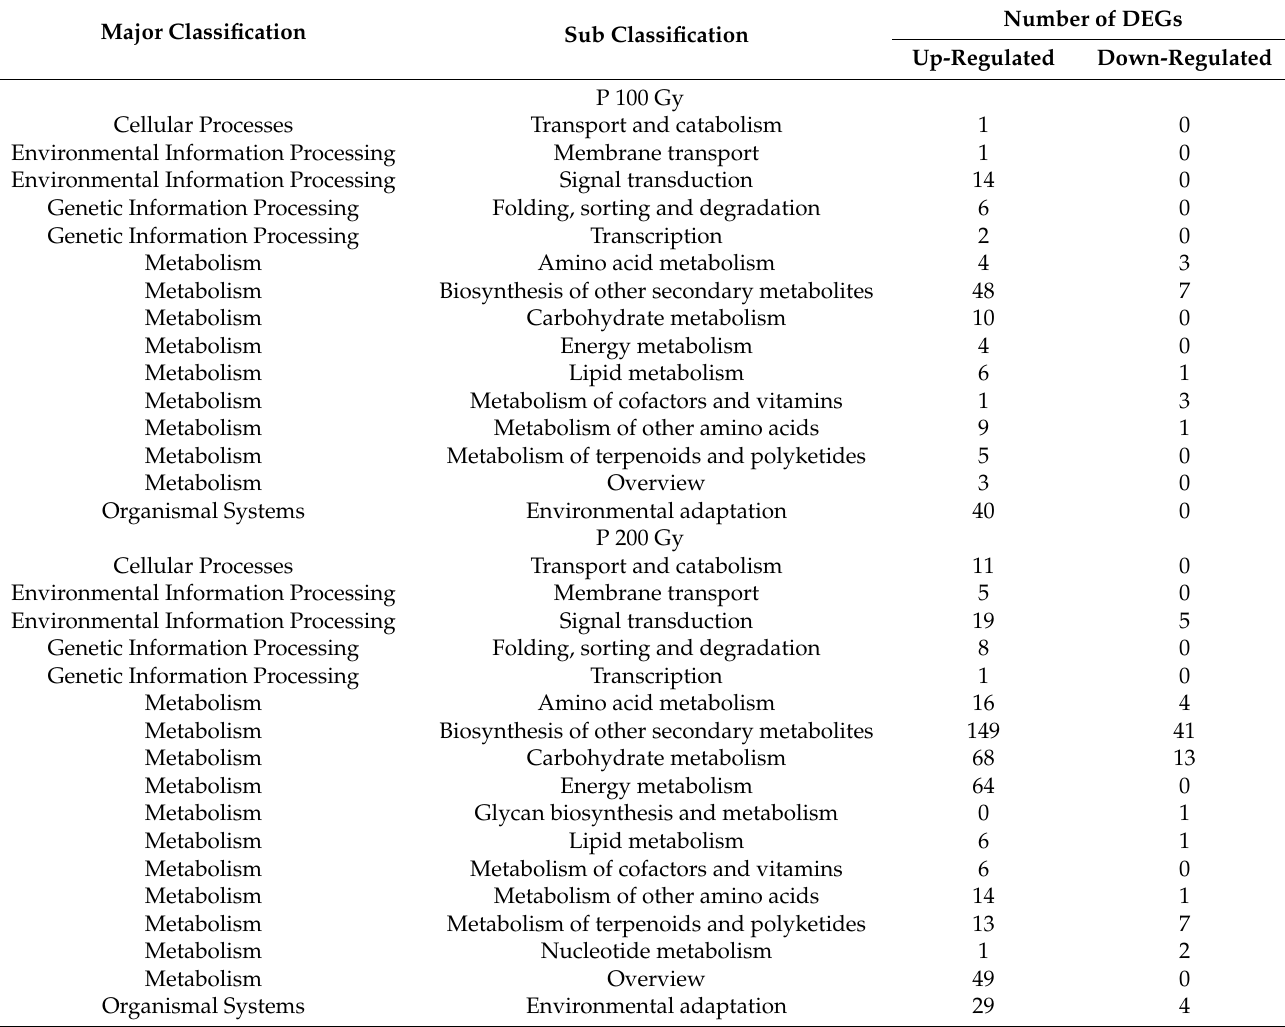
Table 2. Kyoto Encyclopedia of Genes and Genomes (KEGG) enrichment analysis of the up- and down-regulated genes in cowpeas exposed to different dose rates of